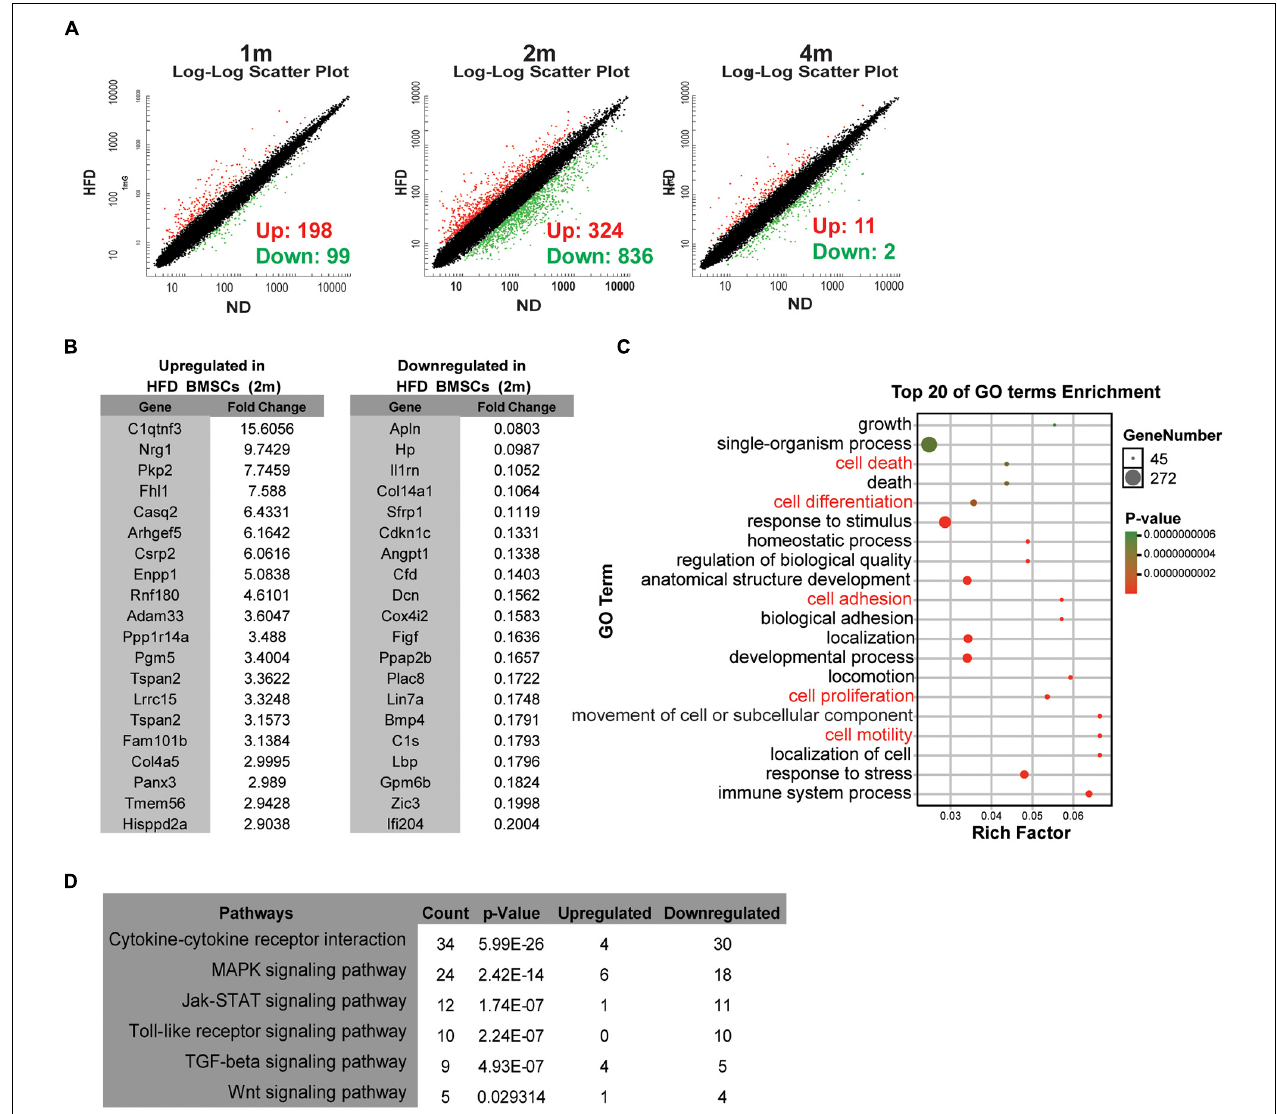
FIGURE 3 | HFD feeding alters the transcription profiles of BMSCs in vivo (A) Microarray analysis of BMSCs isolated from ND rats and HFD rats. Scatter plots of the BMSCs from rats in specified diets for 1 month (1 m), 2 months (2 m) and 4 months (4 m). (B) Lists of the top 20 up-regulated and down-regulated genes in HFD BMSCs compared with ND BMSCs. (C) The bubble chart shows Gene Ontology (GO) enrichment analysis in HFD BMSCs. (D) The enriched KEGG pathways in HFD BMSCs. n =